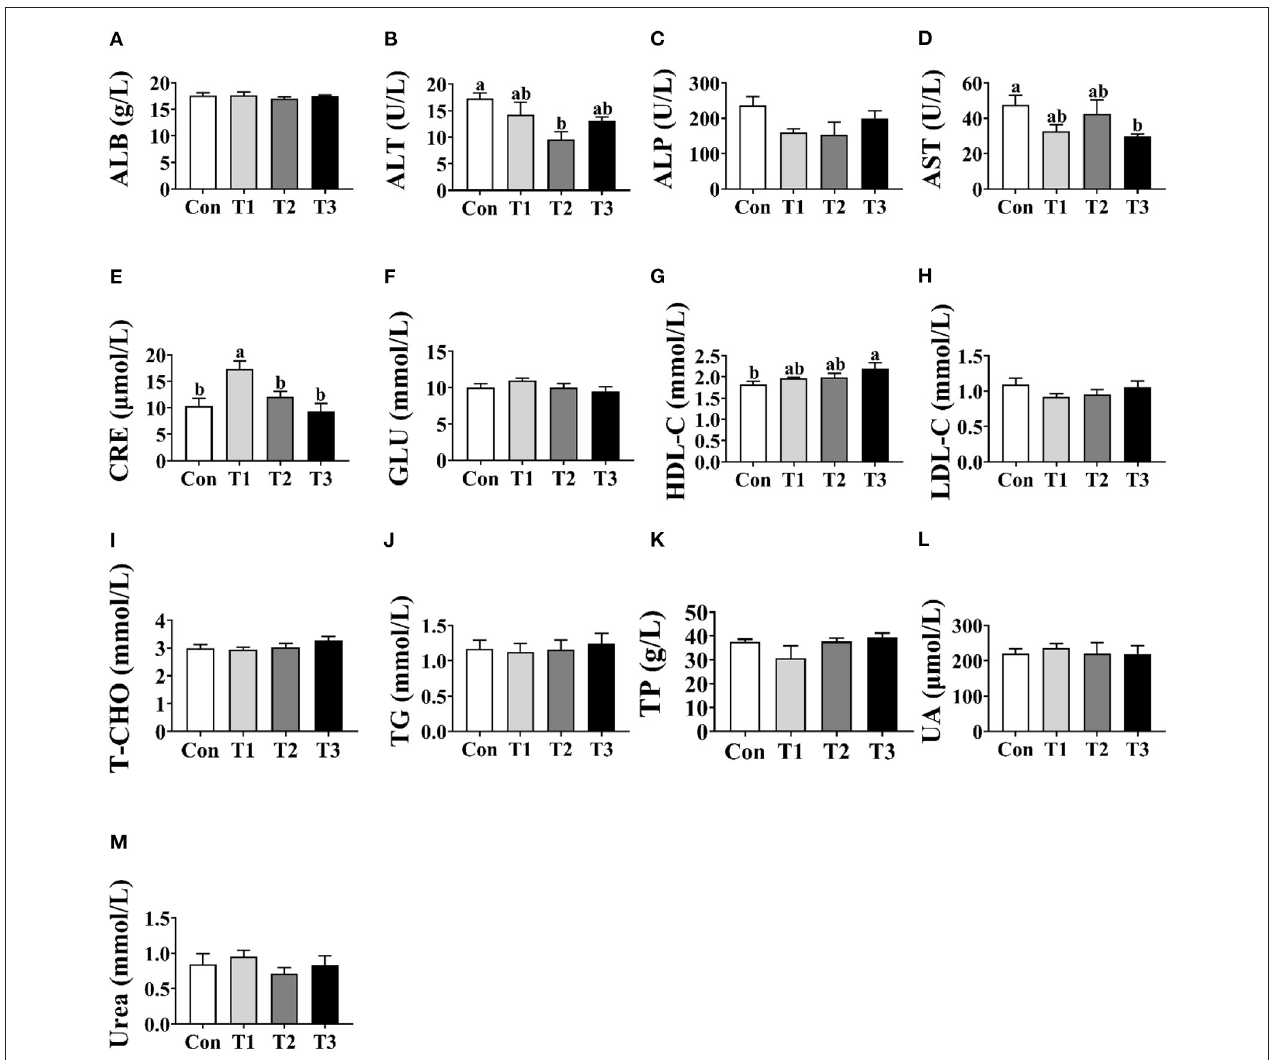
FIGURE 1 | Effects of dietary supplementation with Elephantopus scaber on serum biochemical indexes of ducks. The concentrations of ALB (A) , ALT (B) , ALP (C) , AST (D) , CRE (E) , GLU (F) , HDL-C (G) , LDL-C (H) , T-CHO (I) , TG (J) , TP (K) , UA (L) , and urea (M) in serum. ALB, albumin; ALT, alanine aminotransferase; ALP, alkaline phosphatase; AST, aspartate aminotransferase; CRE, creatinine; GLU, glucose; HDL-C, high-density lipoprotein-cholesterol; LDL-C, low-density lipoprotein-cholesterol; T-CHO, total cholesterol; TG, triglyceride; TP, total protein; UA, uric acid.